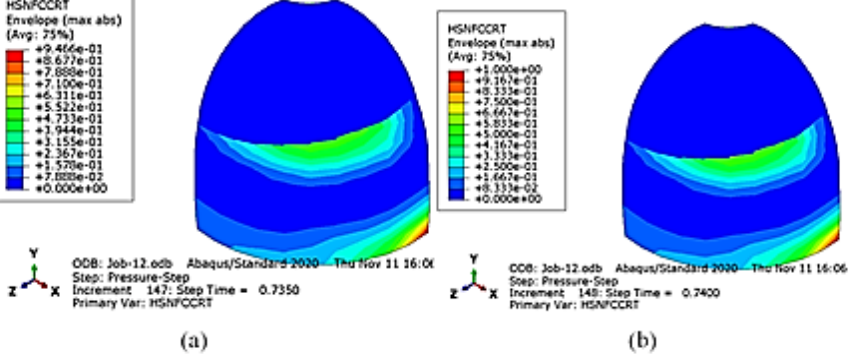
Figure 12. Hashin fiber compression failure index (HSNFCCRT): ( a ) lower than 1 at load step 0.735, and ( b ) greater than 1 at load step 0.74.